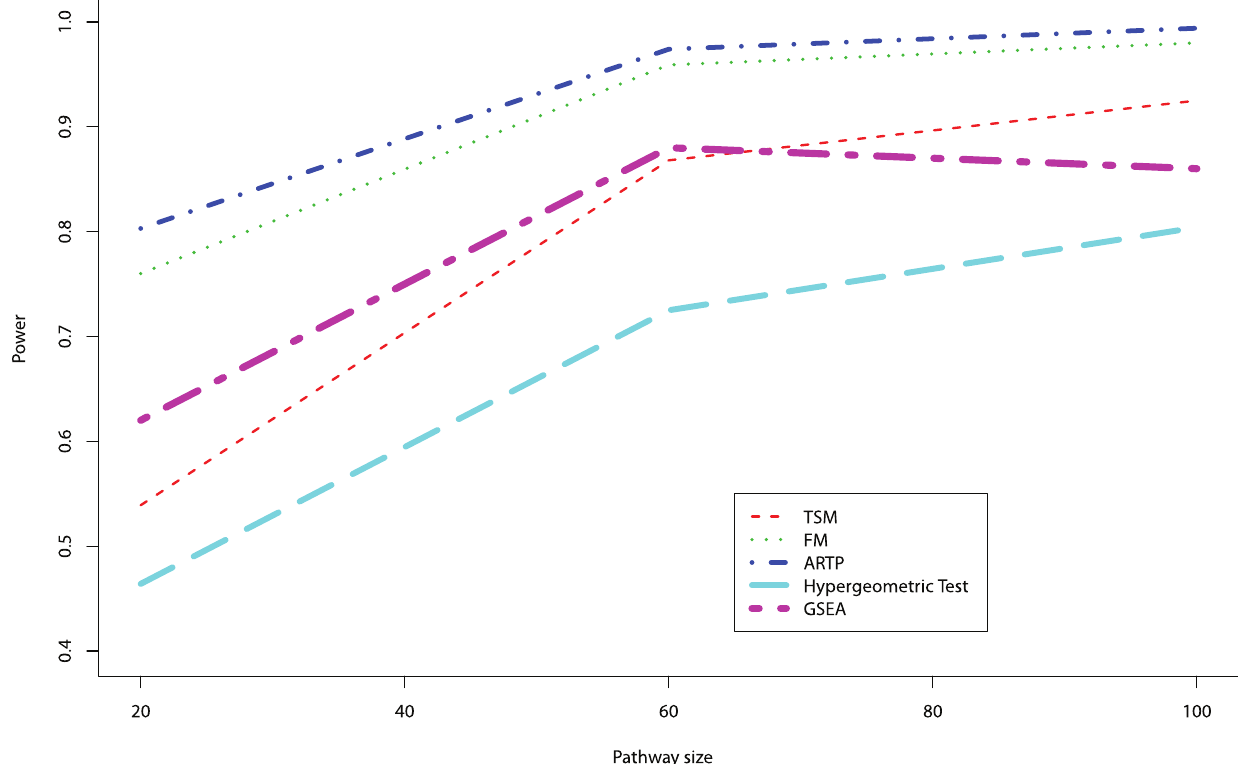
Figure 1. Power of the five methods for different pathway sizes. Plots illustrate the power of the methods when the total number of associated SNPs equals 100, the proportion of associated SNPs within each pathway is 0.4 and the effect sizes are s 2